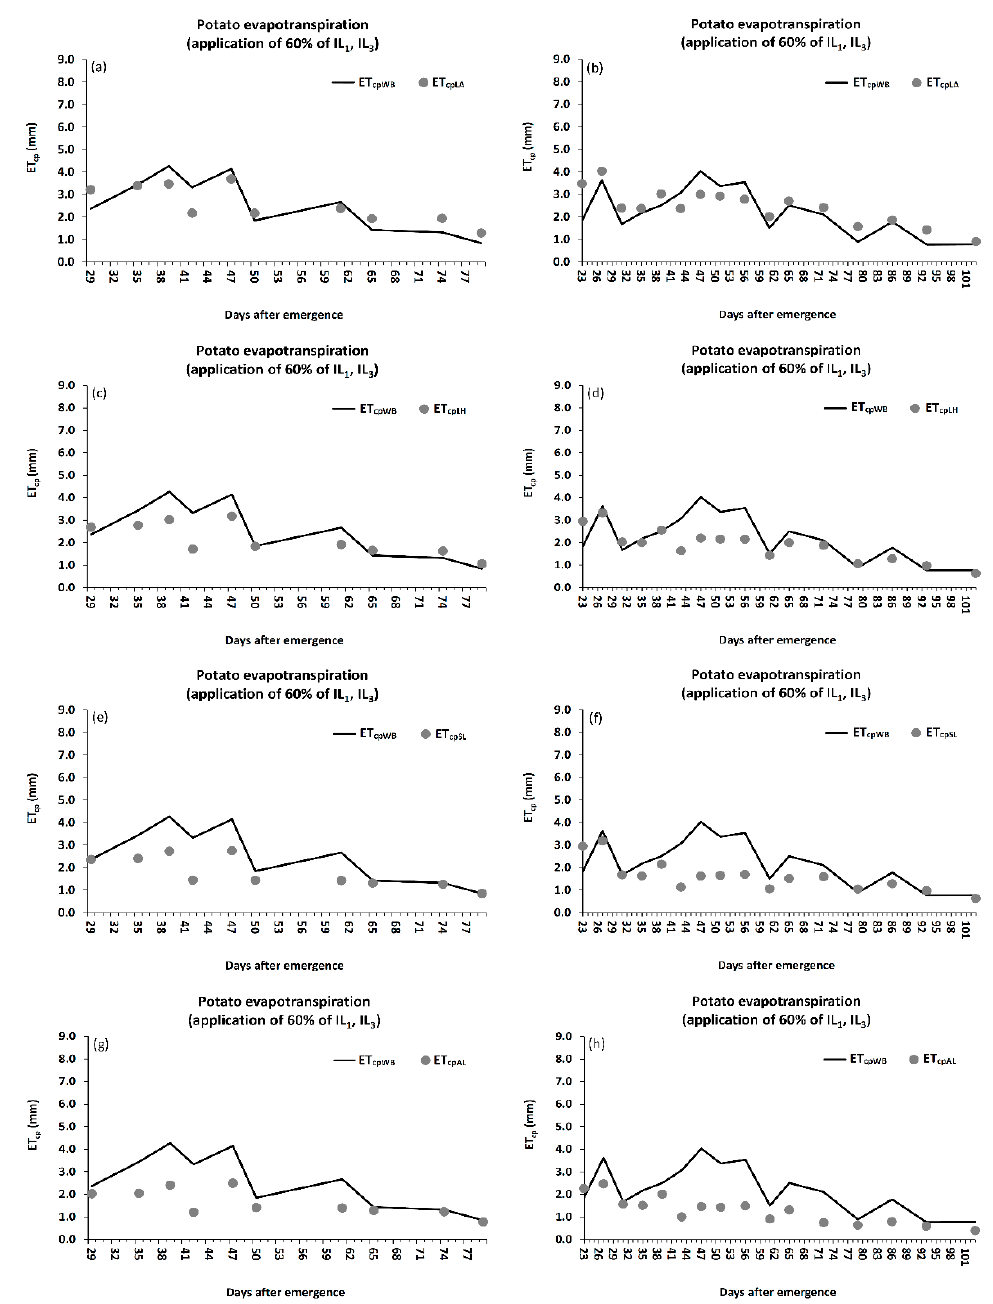
Figure 12. Comparison of daily average ET cp by soil water balance method and PM method with different canopy resistance approaches on an application of 60% of IL 1 (IL 3 ) for 2018/2019 ( a , c , e , g ) and 2019/2020 seasons ( b , d , f , h ).